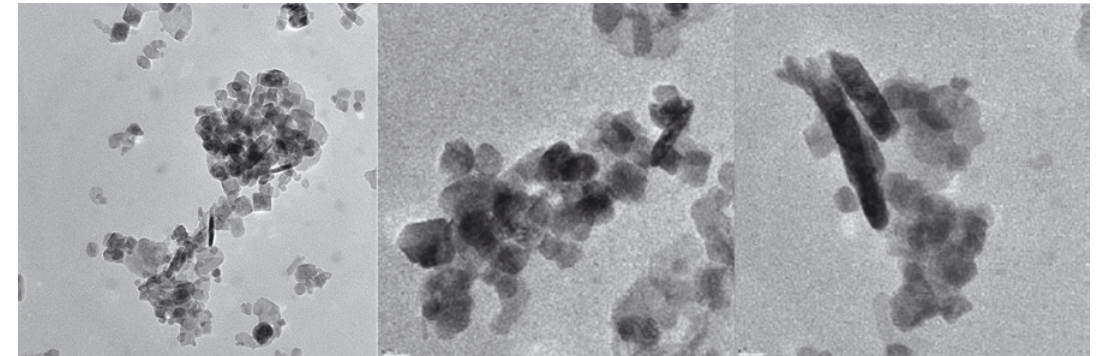
Figure 3. TEM micrographs of as-synthesized Mn of each micrographs with 50 nm